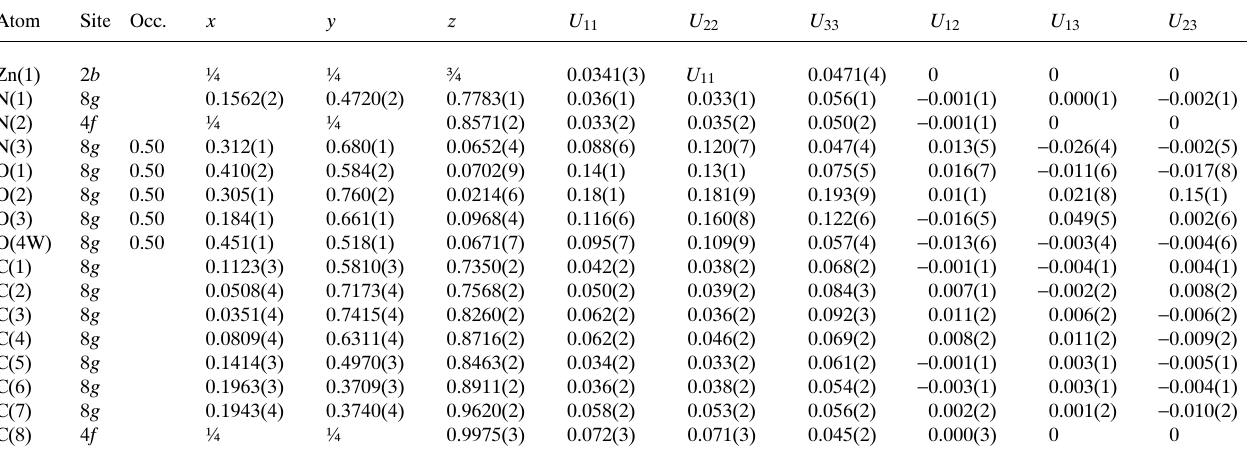
Table 3. Atomic coordinates and displacement parameters (in Å 2 )